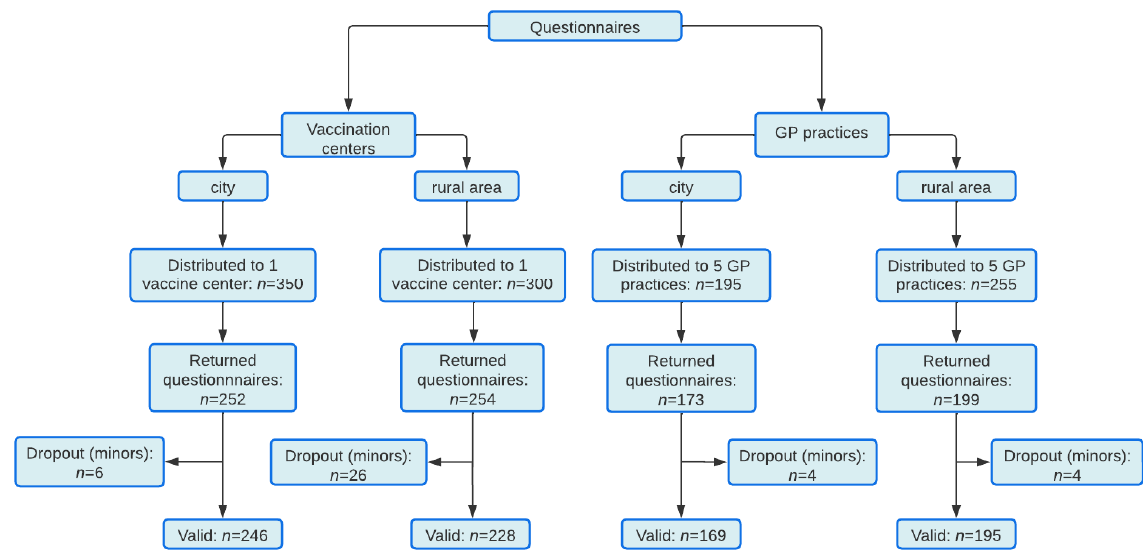
Figure 1. Flowchart of recruitment process.